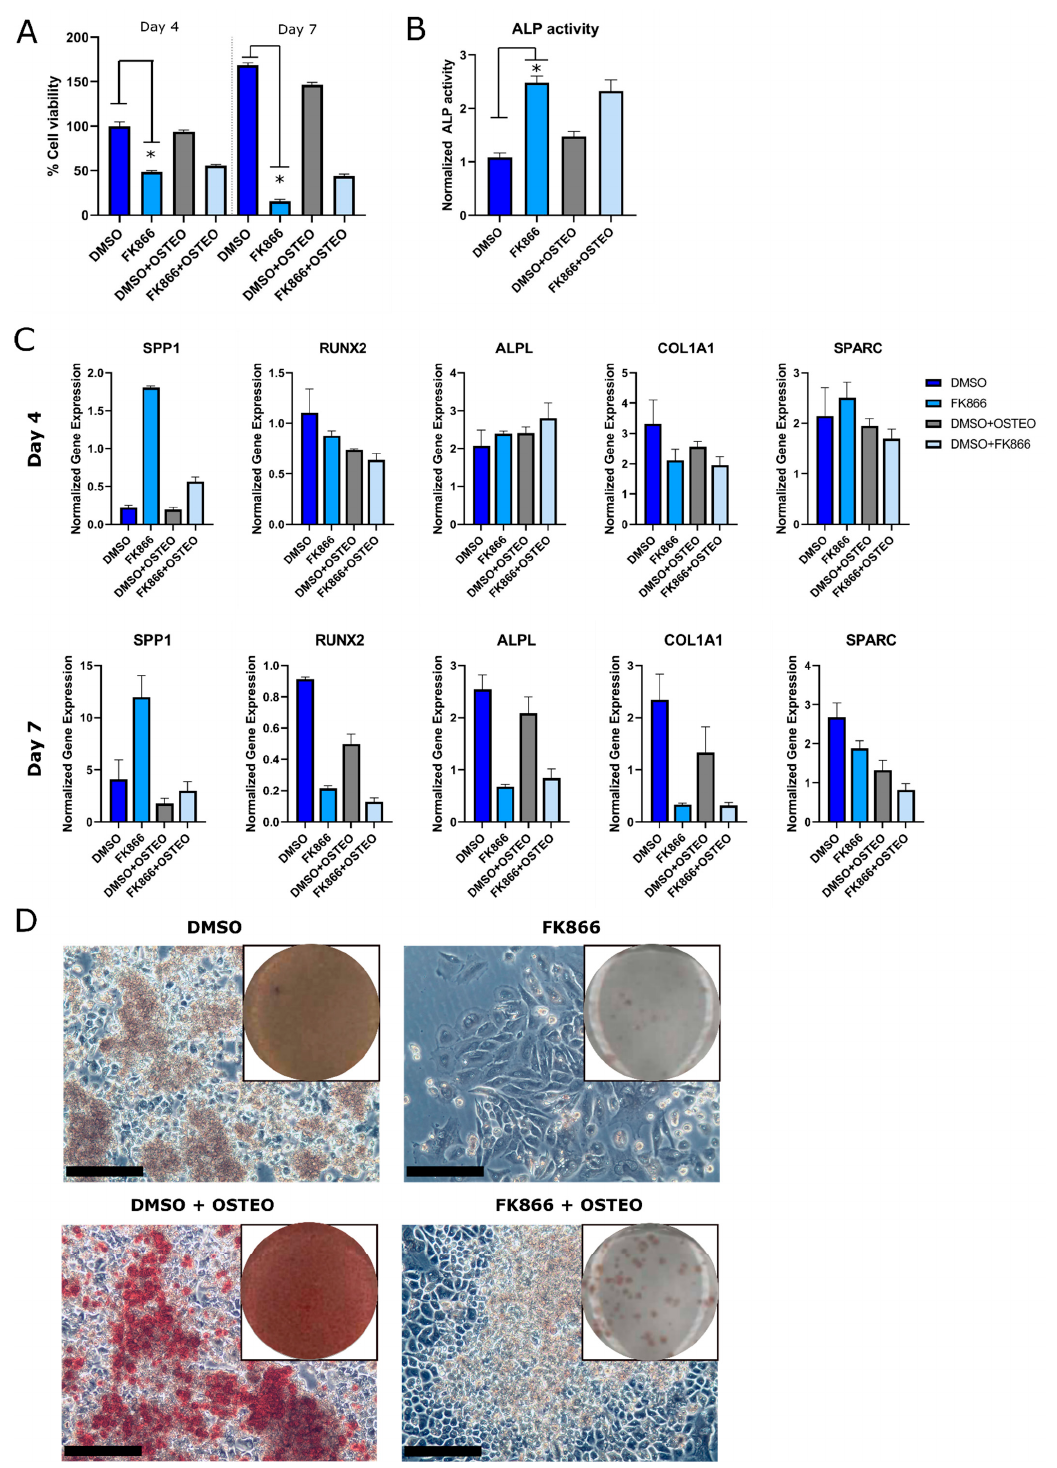
Figure 4. Effect of FK866 on osteogenic differentiation in OS cell line ZK58 is dependent on the duration of treatment. All bars represent the mean of two experiments in triplicate ± standard deviation. * = p < 0.05. ( A ) Only the FK866 treatment (25 nM), and not the osteogenic medium, affects cell viability. ( B ) ALP enzymatic activity increases after four days of FK866 treatment (25 nM). ( C ) Osteogenic gene expression marker SPP1 is upregulated after four or seven days of FK866 treatment (25 nM), whereas markers ALPL , COL1A1 , SPARC, and RUNX2 are downregulated after seven days of treatment. ( D ) Mineralization was inhibited in FK866 (25 nM) treated OS cells, after 21 days of osteogenic differentiation. One representative image is shown for each condition. Scale bar represents 100 µ